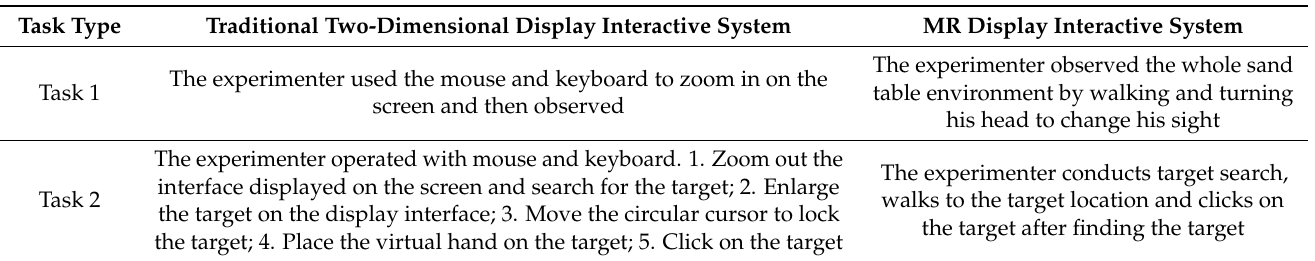
Table 1. Operation steps of each task completed by the two display interactive